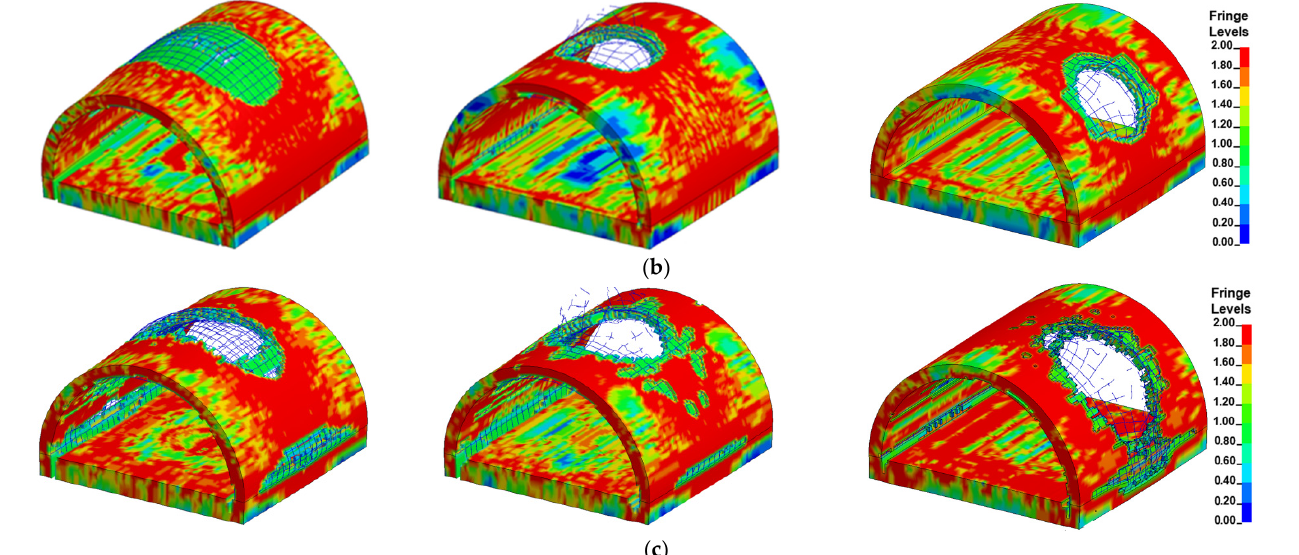
Figure 11 . Damage pattern of the prototype of tunnel entrance under given explosive mass ( a ) W = 454 kg; ( b ) W = 1814 kg; ( c ) W = 4536 kg; (The detonation points are: center, tunnel crown and tunnel hance from left to right). Table 12. Residual bearing capacity of the prototype of tunnel entrance with given explosive mass. Residual Bearing Capacity (kN) Position of the Detonation Point